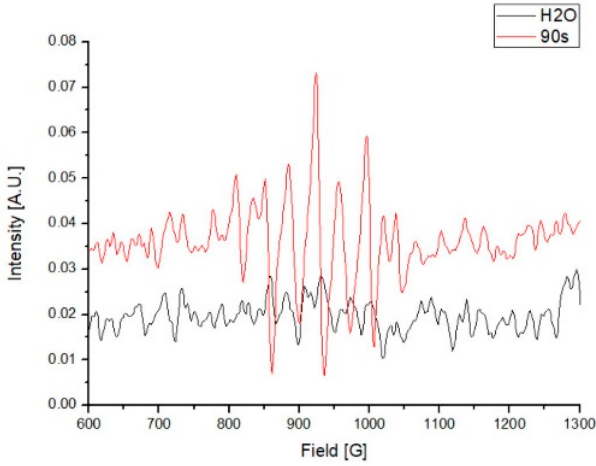
Figure 3. Electron paramagnetic resonance (EPR) of the plasma-activated water (PAW) in 1000 mL.